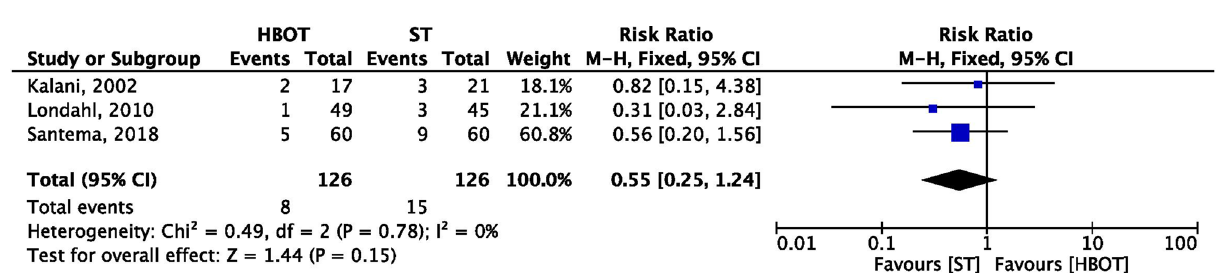
Figure 9. Forest plot of comparison: HBOT versus ST, Outcome: